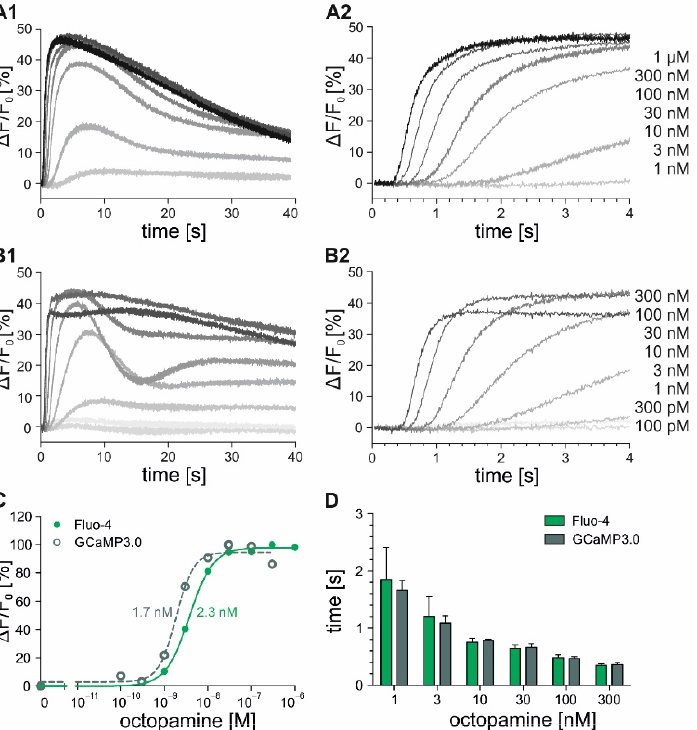
Figure 3. Stopped-flow experiments with DmOct α 1B- and DmOct α 1B-GCaMP3.0-expressing cell lines. Fluo-4-loaded DmOct α 1B ( A ) and DmOct α 1B-GCaMP3.0 ( B ) cells were stimulated with in- creasing octopamine concentrations ranging from 10 − 10 –10 − 6 M in stopped-flow measurements. Fluo- rescence was monitored over 40 s and fluorescence changes ( Δ F/F 0 ) for each octopamine concentra- tion were calculated and plotted against the time ( A1 , B1 ). To resolve the initial signal response times, the first 4 s of each measurement were analyzed and are shown ( A2 , B2 ). Representative measure- ments from three independent datasets are shown. Each data point was obtained from triplicate measurements; ( C ) Concentration–response curves were established by plotting maximal changes in fluorescence against octopamine concentrations. Maximal changes in fluorescence ((F max − F 0 )/F 0 = Δ F/F 0 ) at the highest octopamine concentration were normalized to 100% and EC 50 values were ob- tained from nonlinear fitting of the data using GraphPad Prism v5.04. A representative concentra- tion–response curve is shown. Mean EC 50 values are indicated from three independent datasets; ( D ) Bar graph indicating the time (s) passed until fluorescence signals were detected with Fluo-4-loaded (green) and GCaMP3.0-expressing (grey) cells (y-axis) and plotted against octopamine concentra- tions. Mean values ± SEM from three independent datasets are shown.